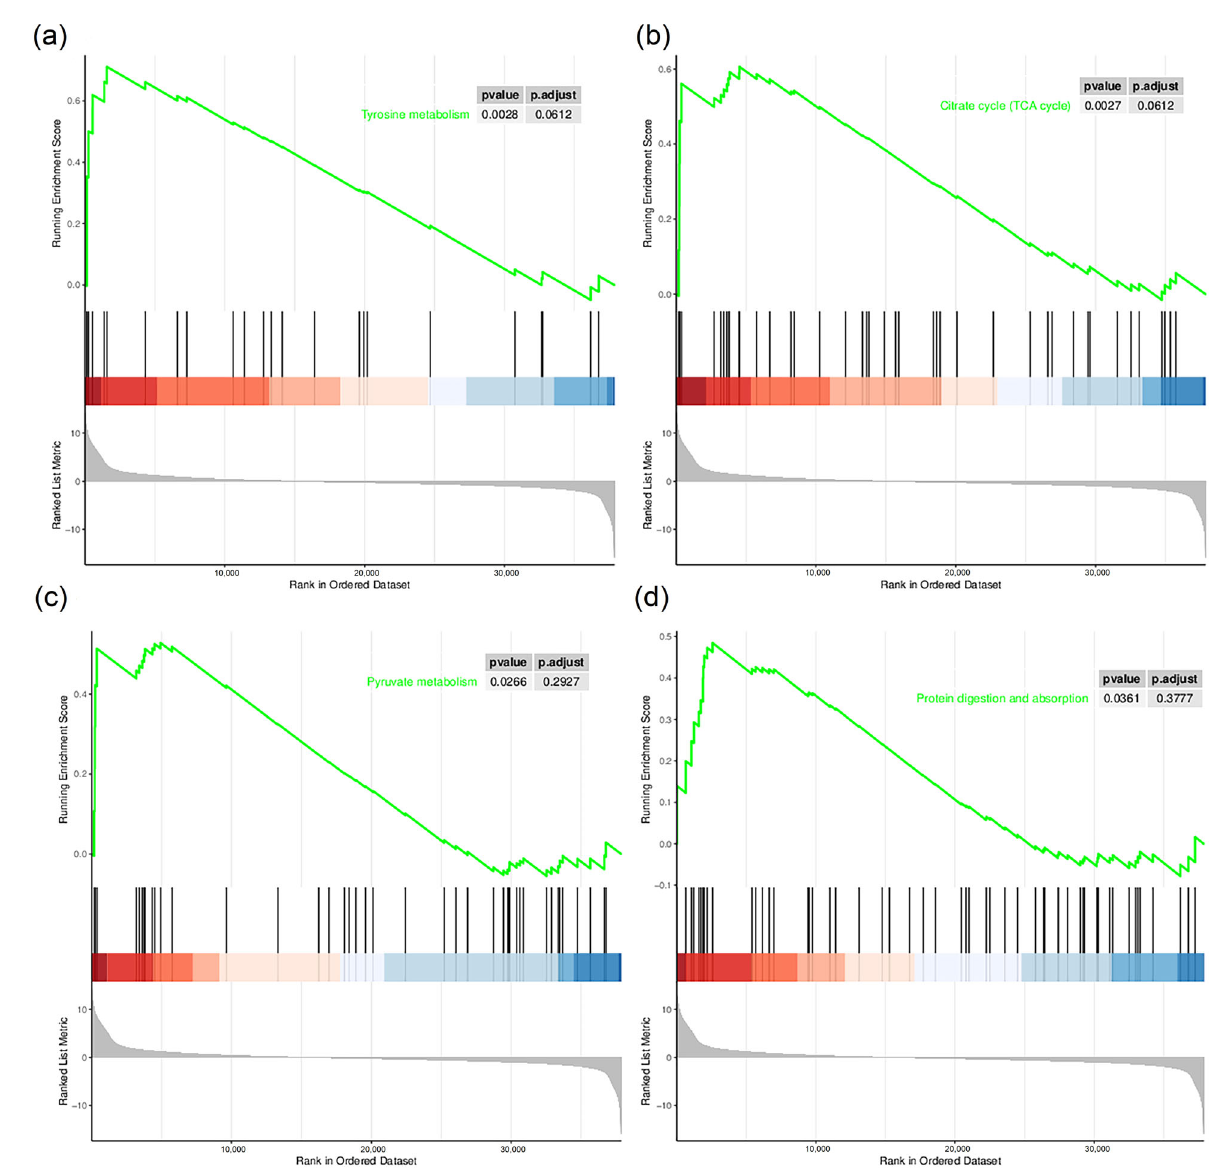
Figure 5. Gene Set Enrichment Analysis (GSEA) of upregulated pathways in gregarious armyworms compared with solitary armyworms. The green curve is an enrichment score line graph, and the score at the peak is the ES value of the gene set. Black lines mark where members of the gene set appear in the gene sequencing list. The grey part is the distribution map of rank values of all genes. ( a ) Tyrosine metabolism; ( b ) the tricarboxylic acid cycle; ( c ) pyruvate metabolism; ( d ) protein digestion and absorption.